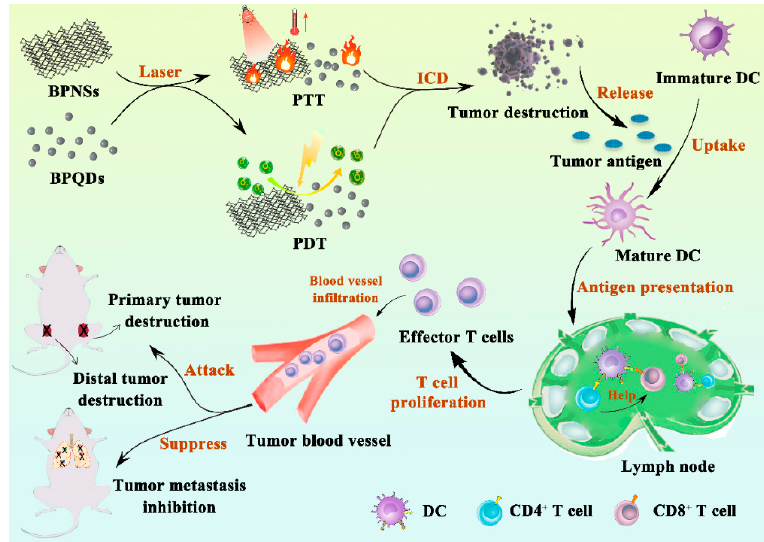
Figure 6. Schematic illustration of the synergistic cancer photoimmunotherapy based on BP nanomaterials. When exposed to specific laser irradiation during anticancer treatment, BP nanomaterials exhibit excellent phototherapy effect, which can not only destroy the tumor in situ, but activate tumor immunity as well. As a result, both subsequent tumor destruction and tumor metastasis inhibition can be acquired through this synergistic anticancer therapy.